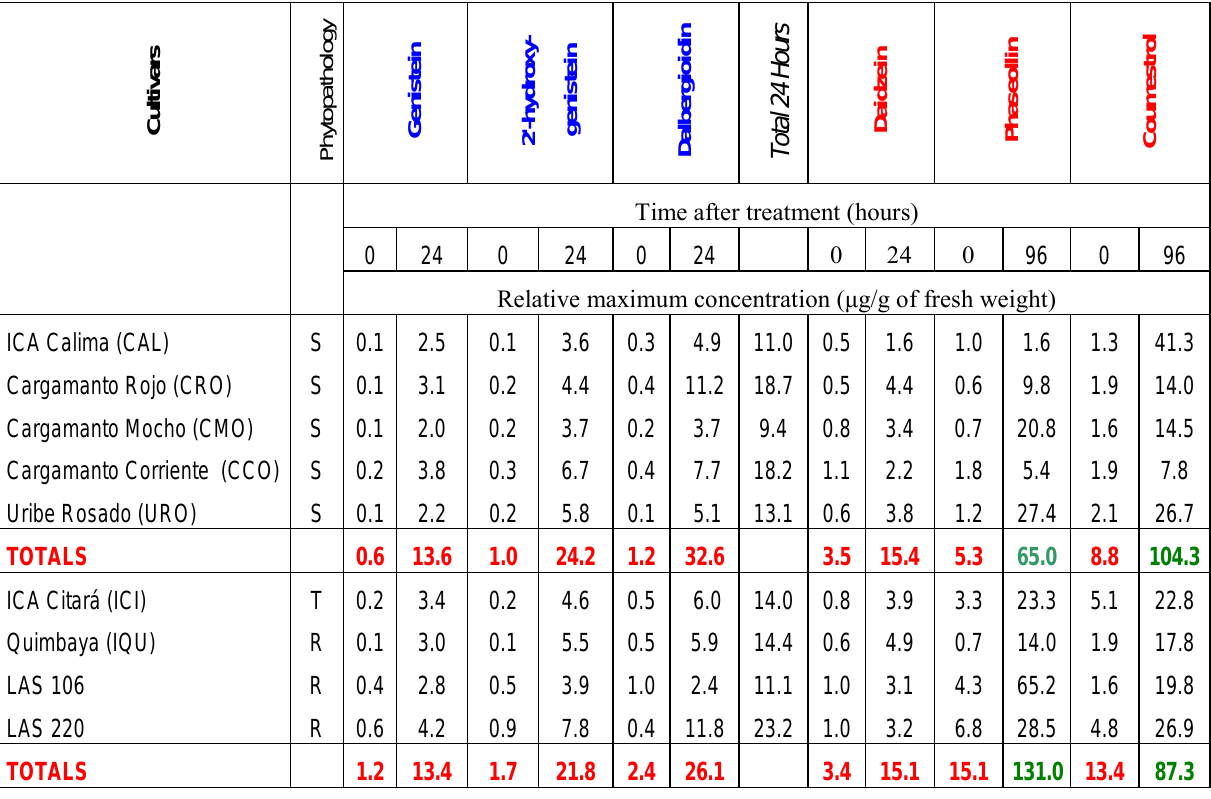
Table 1. Correlations between phytopathology and production of phytoalexins in Colombian bean cultivars, R: resistent, T: tolerant, S: susceptible to C. lindemuthianum.